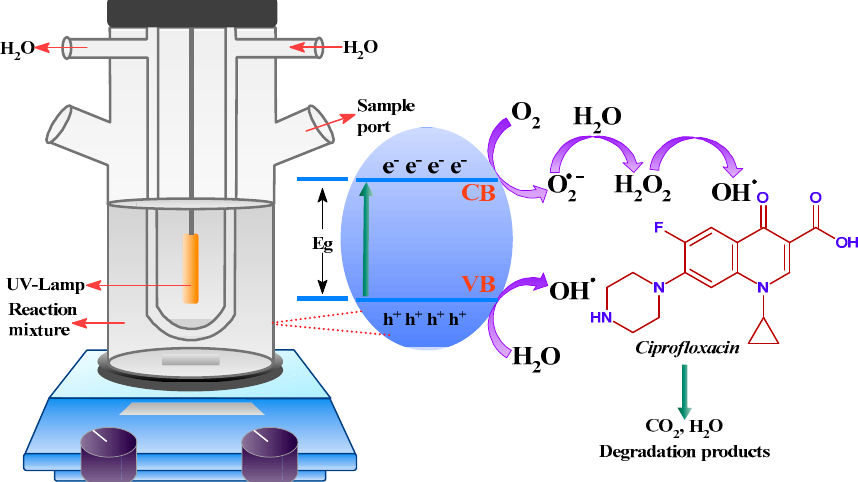
Figure 12. Schematic representation of photocatalytic degradation and mechanism after photodegradation via a catalyst (LP-ZnO NPs).